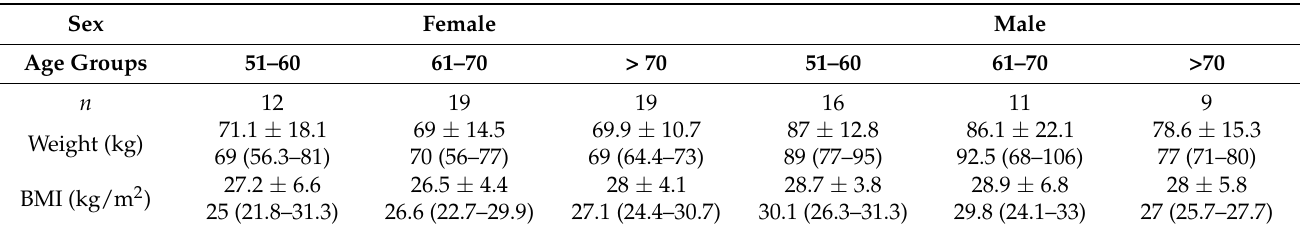
Table 2. Number of patients, BMI (kg/m 2 ), and weight (kg) (mean ± SD and median (Q1–Q3)) of the patients in the sex and age groups ( N = 86).